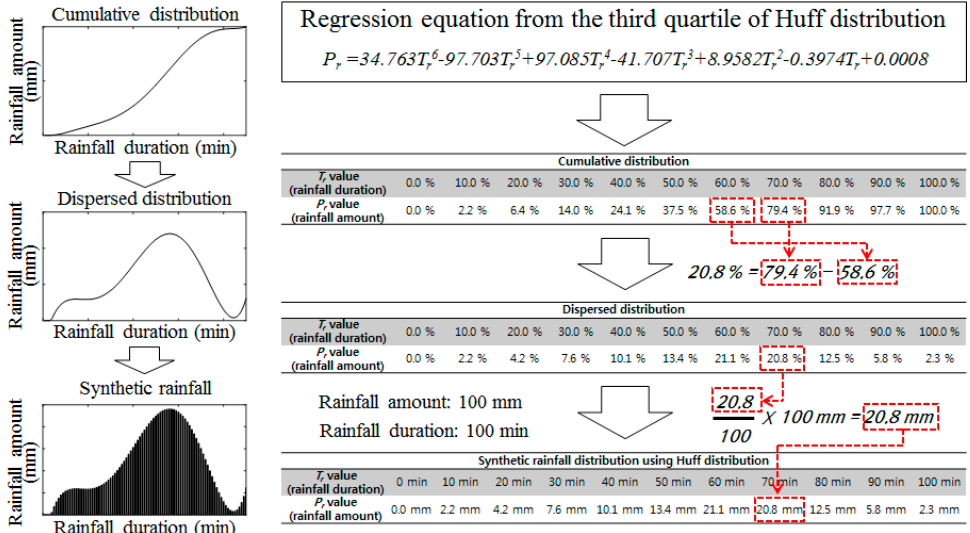
Figure 1. Generating process of synthetic rainfall data using the Huff distribution.